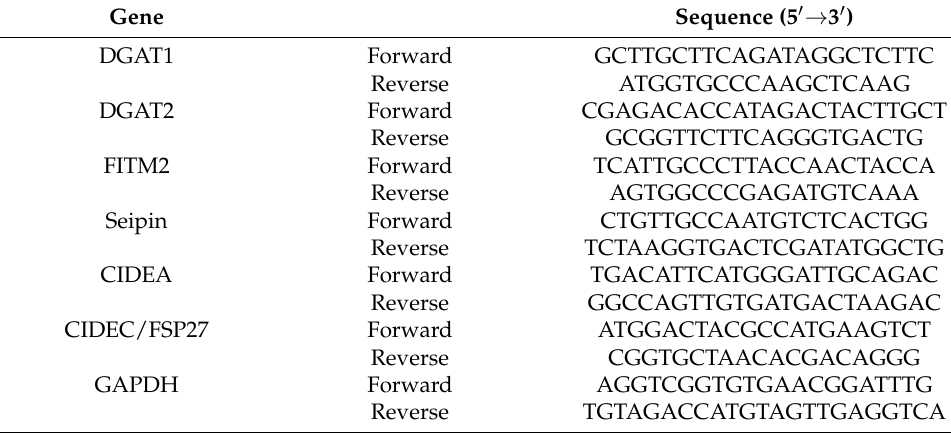
Table 1. Primers